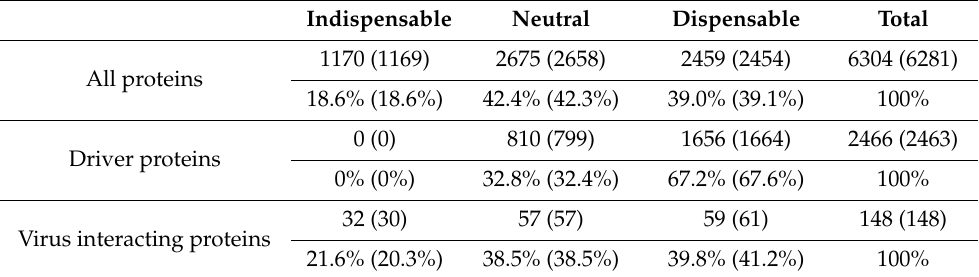
Table 2. The number of proteins in each robust controllability category for all proteins, driver proteins, and SARS-CoV-2 interacting proteins. Values are reported as totals and percent total for the VIN